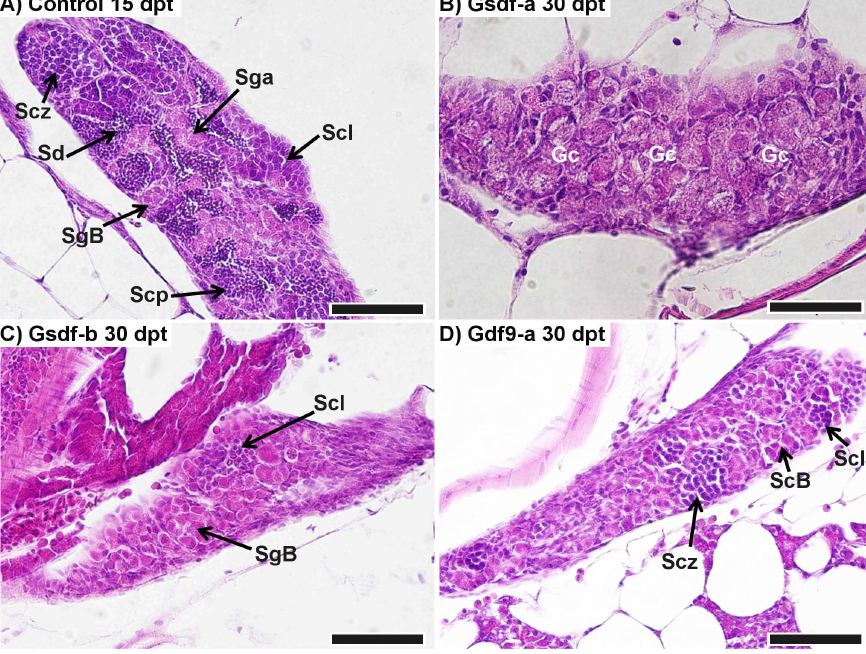
Figure 5. Retardation in testis development. A) Representation of normally developing testis in a control male (78.0 mg, 21.5 mm) at 15 days post treatment (dpt). B) Retarded development in an anti-Gsdf-a treated male at 30 dpt (132.0 mg, 25.5 mm): initial phase of differentiation with only undifferentiated gonocytes visible. C) Testis of an anti-Gsdf-b treated fish at 30 dpt (108.5 mg, 24.0 mm): the testis consisted predominantly of spermatogonia with the start of the spermatocyte phase visible. D) Testis of an anti-Gdf9-a treated fish at 30 dpt (89.4 mg, 22.4 mm): spermatocytes reached the zygotene stage of meiotic